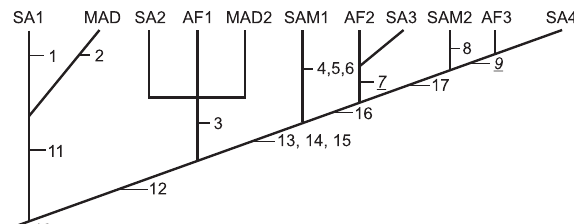
Figure 3. Taxa/area cladogram presenting the general pattern of distribution among cuckoos subfamilies and reticulated Gondwana- land areas, except for Australia and Antarctic. (AF) Africa, (MAD) Madagascar, (SA) Southeast Asia, (SAM) South America, (1) Carpococcyx , (2) Coua , (3) Centropus , (4) Neomorphinae, (5) Crotophaginae, (6) Taperinae, (7) Phaenicophaeinae, (8) Saurotherinae, (9) Cuculinae, (10-17) arbitrary numbers showing the relationships among taxa. The numbers in italic and underlined represent the homoplasies where areas duplications are